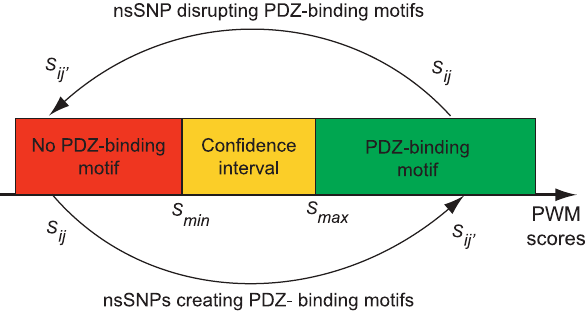
Figure 2. nsSNPs can disrupt a PDZ-binding motif, create a new one, or not have an effect. The two arrows illustrate our algorithm to predict the first two cases. A nsSNP is considered to disrupt a PDZ- binding motif if the wild-type sequence ( j ) has a score S ij . S max (green box), while the modified sequence ( j 9 ) has a score S ij 9 , S min (red box) with at least one PDZ domain ( i ) (upper arrow). Reversely, nsSNPs can create new PDZ binding motifs if S ij , S min and S ij 9 . S max (lower arrow). The confidence interval (yellow box) is used to ensure that the scores are different enough between the wild type and the mutant to predict nsSNPs effect on PDZ mediated interactions. Figure 3. nsSNPs disrupting PDZ-binding motifs are only